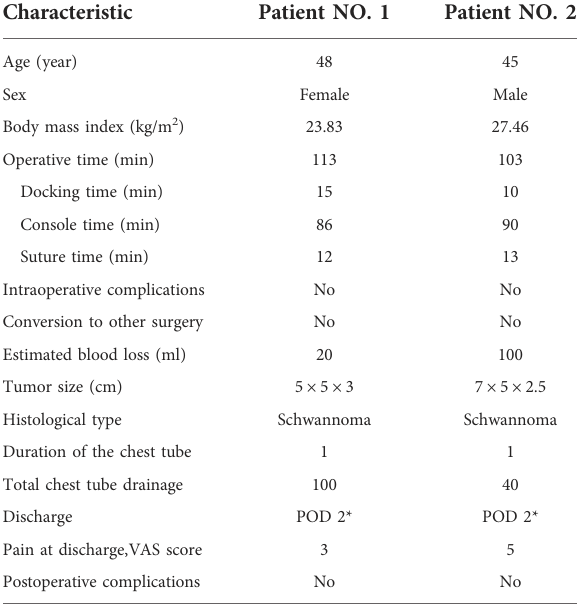
TABLE 1 Patients ’ characteristics and perioperative data.